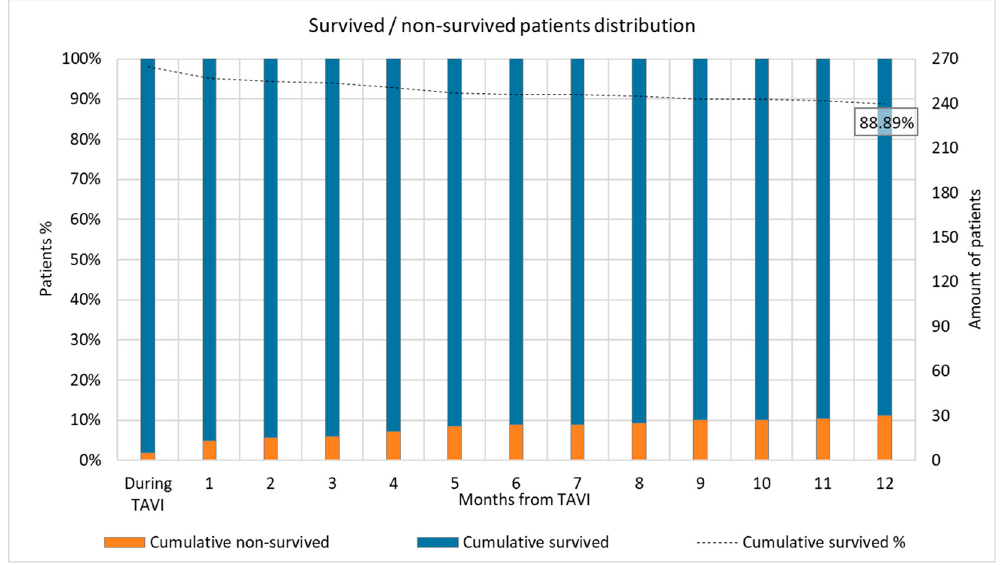
Figure A2. Survival distribution over the first year.